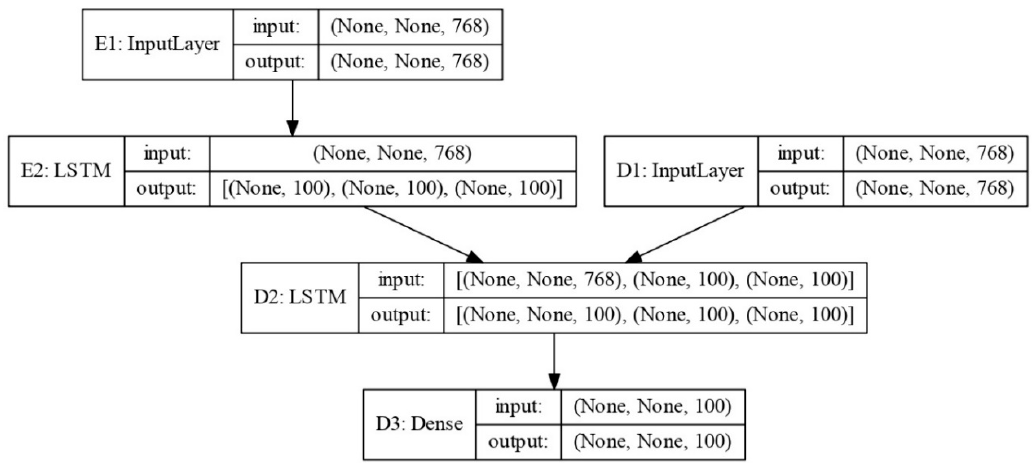
Figure 2. One-layer long short-term memory (LSTM) for encoder and decoder (abbreviated as LSTM encoder and decoder). E1, E2 represent the encoder; D1, D2, D3 represent the decoder.